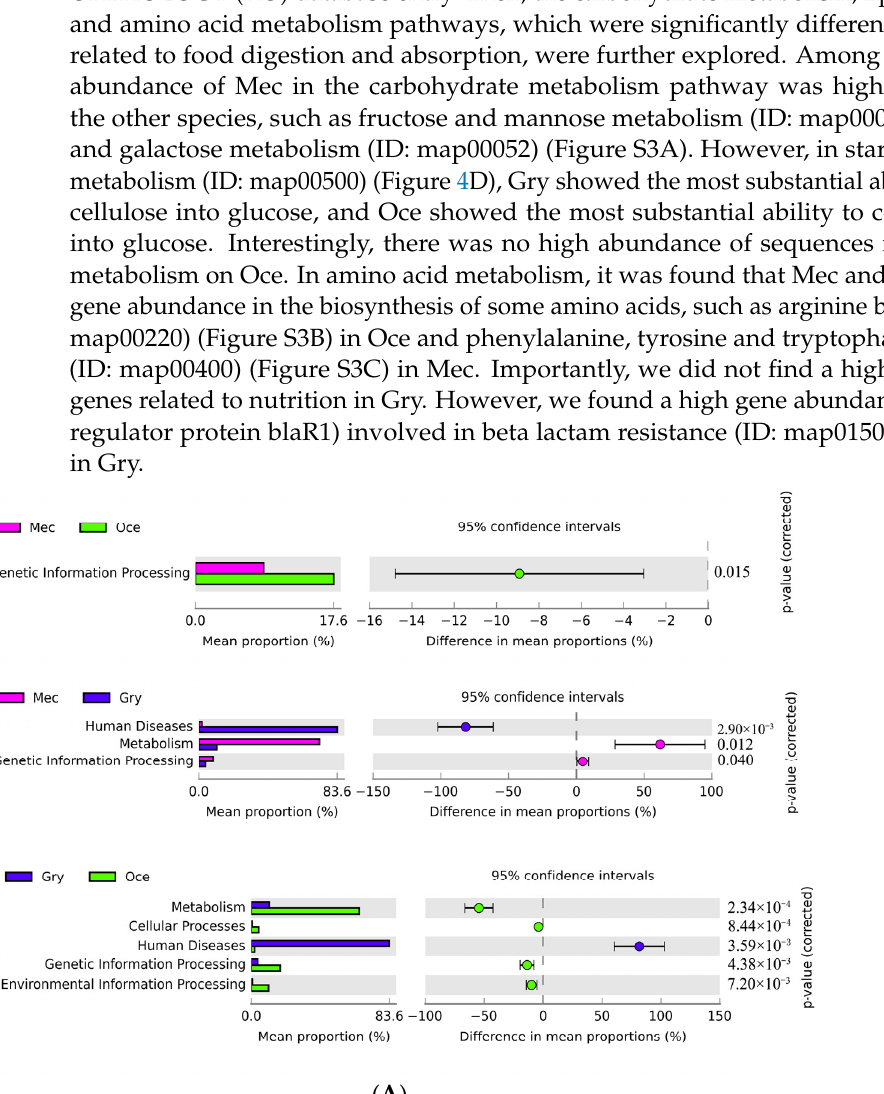
Table 3. The percent of gut microbiota was assigned to biological functions.